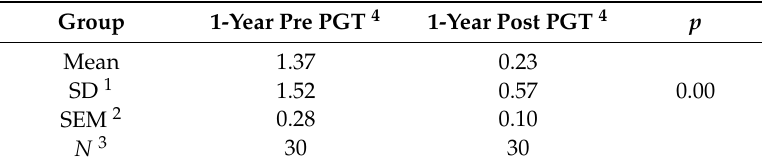
Table 2. Number of hospitalizations: mirror analysis.